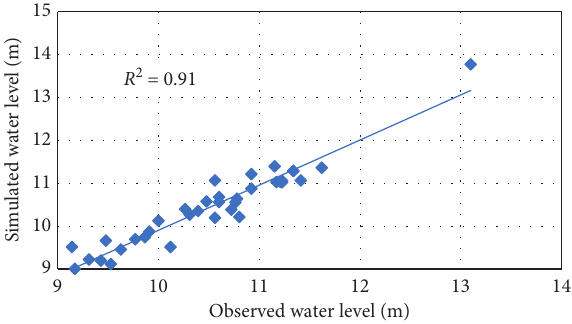
Figure 7: Observed versus simulated water surface